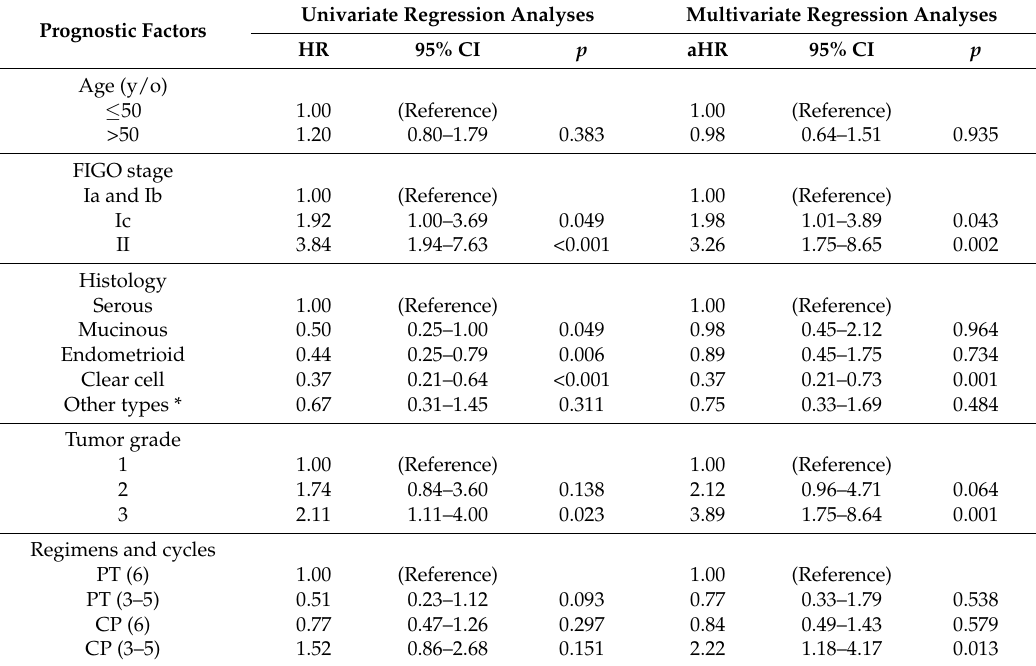
Table 1. Prognostic factors for 5-year disease-free survival (DFS) of 437 early stage ovarian cancer women by univariate and multivariate Cox regression analyses. Univariate Regression Analyses Multivariate Regression Prognostic Factors